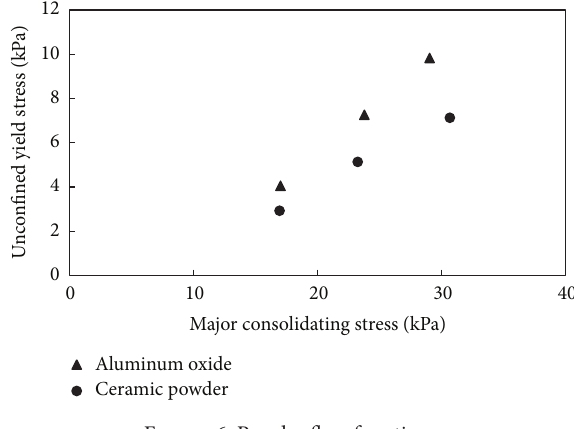
Figure 6: Powder flow